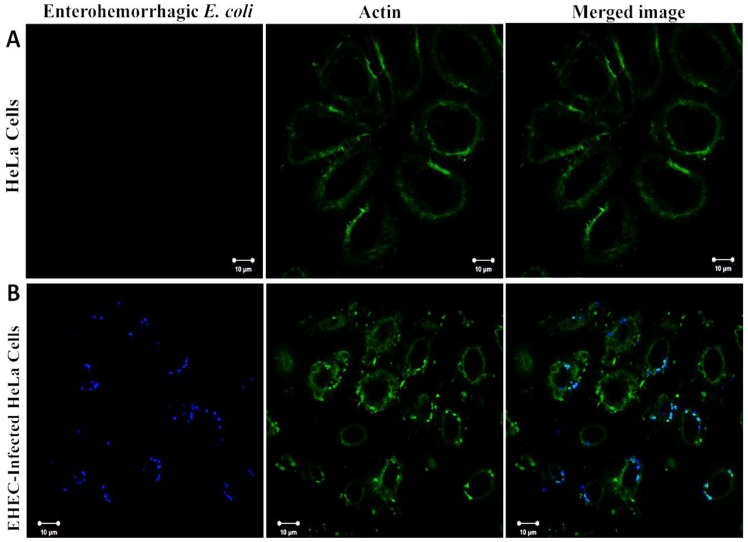
Immunofluorescence microscopy images of the apical region of HeLa cells without vs. with EHEC infection.(A) HeLa cells without EHEC infection; (B) HeLa cells, after being infected with EHEC for 6 hours. HeLa cells were fixed, permeated and stained: green, FITC-label phalloidin for actin; blue, rabbit anti-O157 and Alexa Fluor 405-goat anti-rabbit IgG for EHEC. The merged images in turquoise represent the EHEC induced pedestal formation.